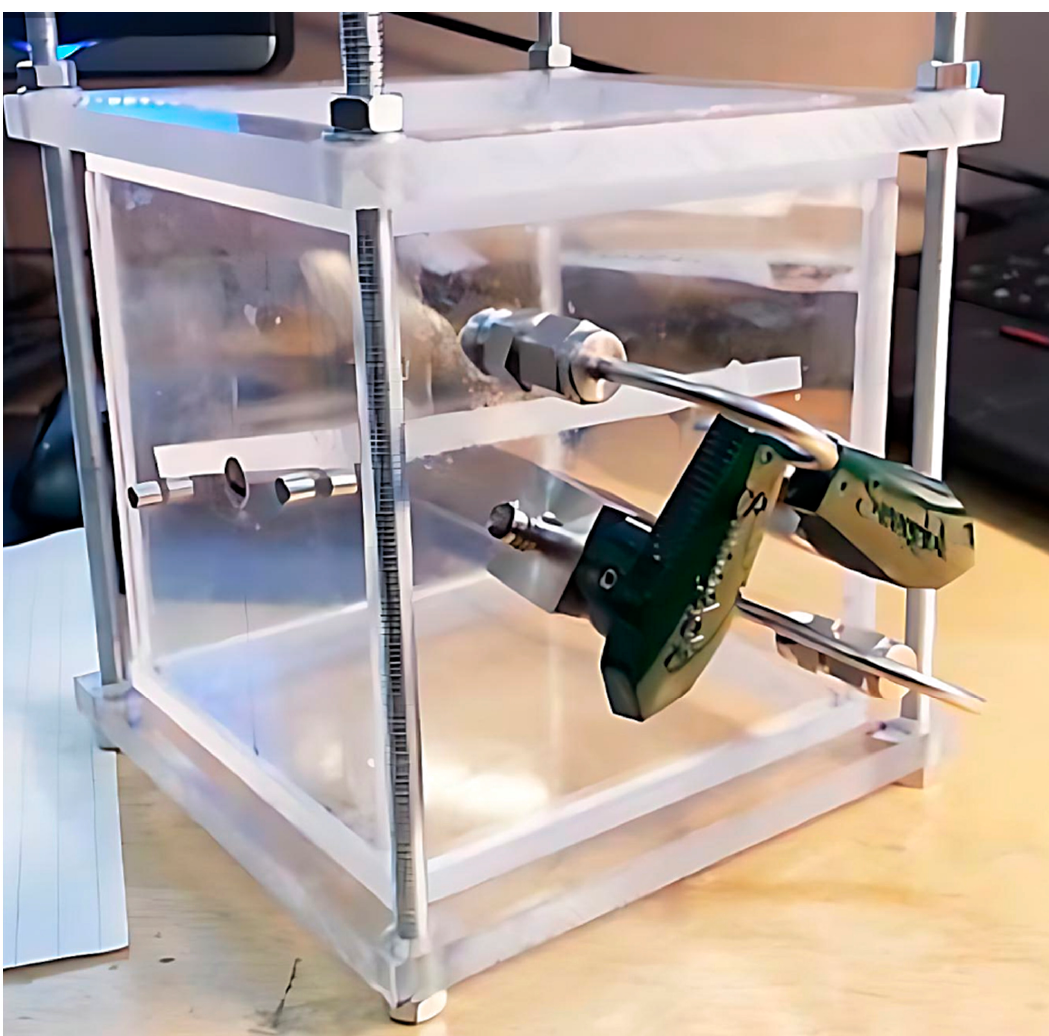
Figure 6. Skylight prototype at the ÅA University, PST laboratory